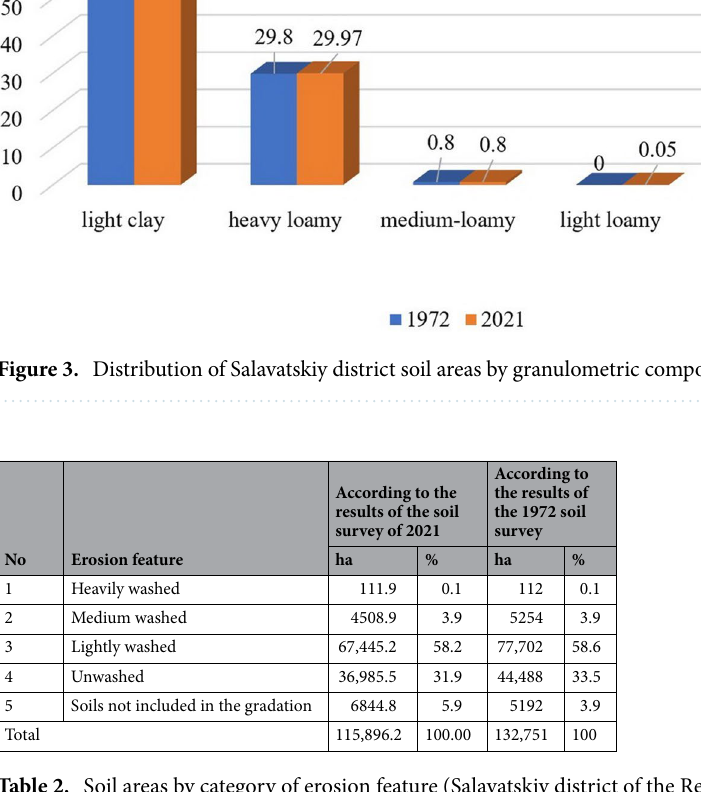
Table 2. Soil areas by category of erosion feature (Salavatskiy district of the Republic of